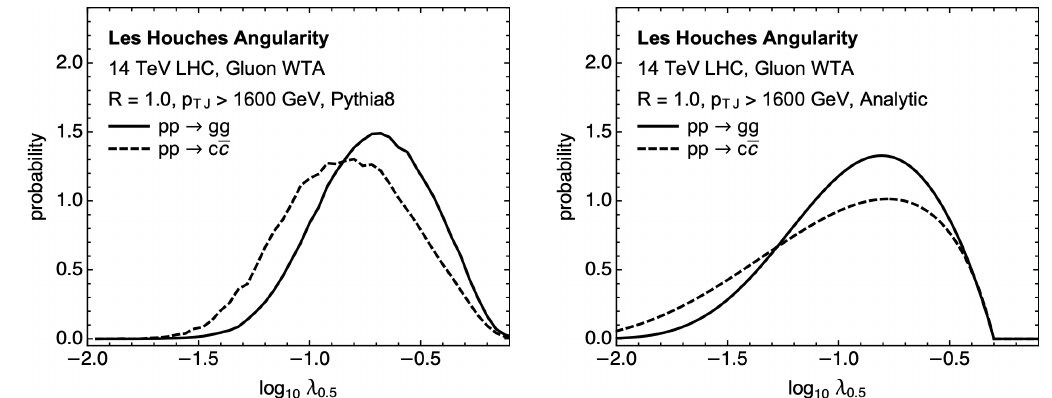
Figure 6 . Distribution of the Les Houches angularity λ 0 . 5 measured about the WTA axis, for gluon- flavor. Different curves correspond to different initiating high-energy processes. Left: distributions from Pythia8 simulation. Right: distributions from our simple analytic